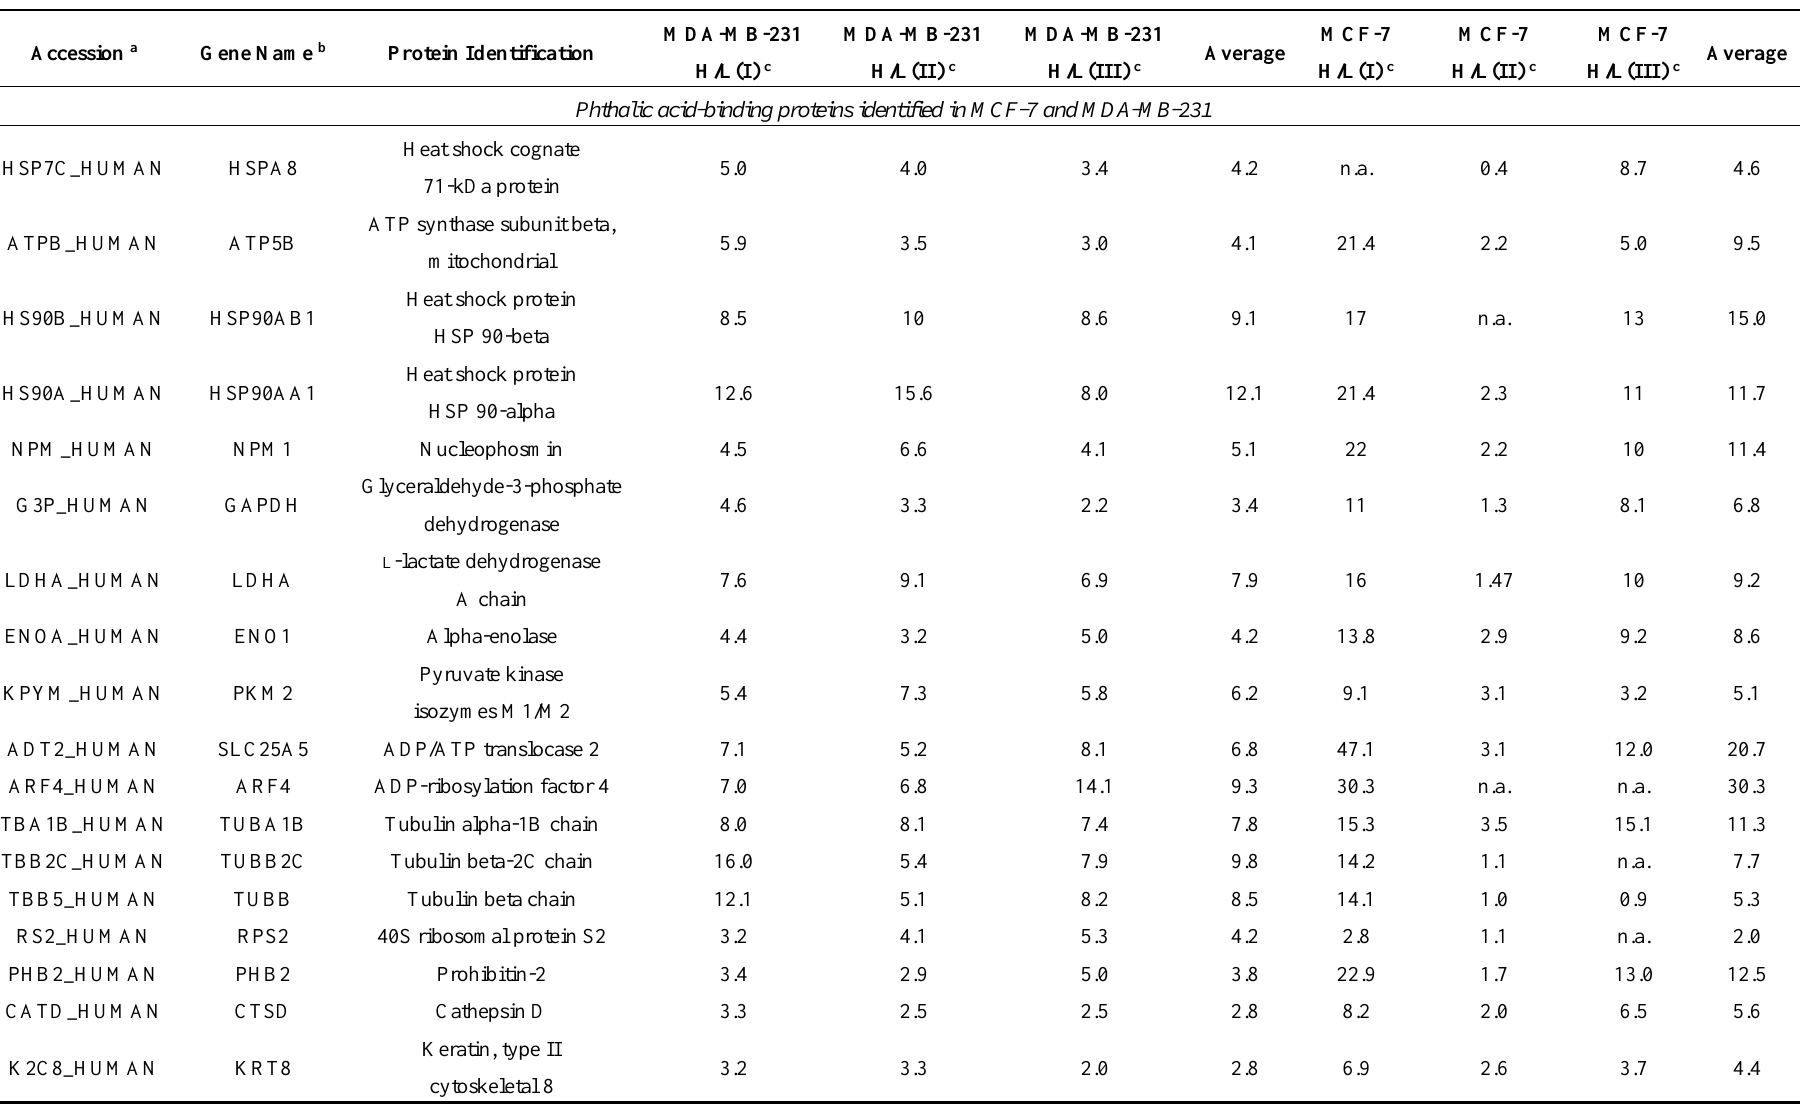
Table 1. Phthalic acid chemical probe related proteins with significant D/H labeling ratios in MCF-7 and MDA-MB-231 breast cancer cell